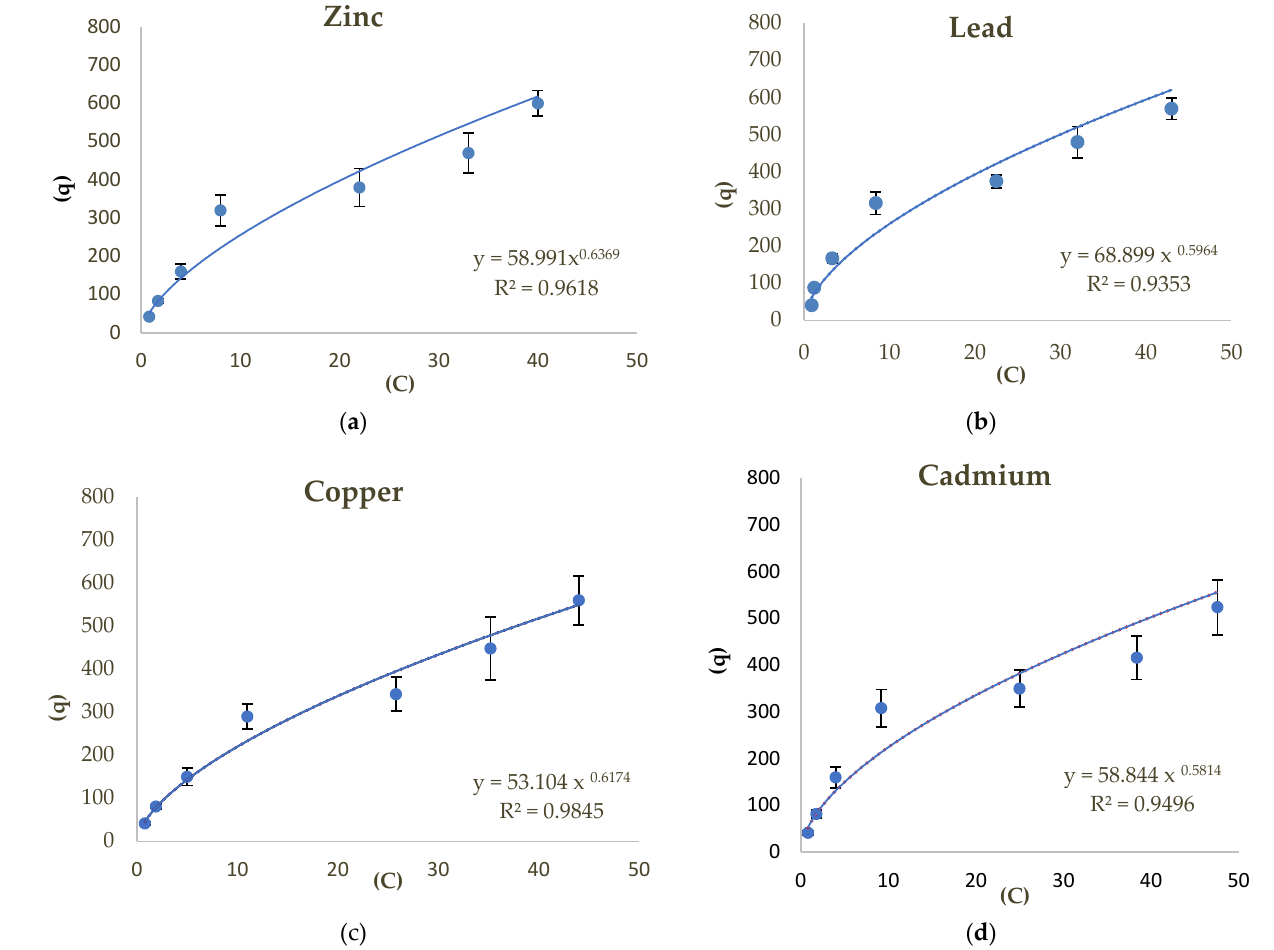
Figure 2. The Freundlich isotherm adsorption of Zn, Pb, Cu, and Cd ( a – d ) in the acidic soil sample. Table 2. Freundlich and Langmuir isotherm parameters for Zn, Pb, Cu, and Cd in both studied soils. Freundlich Parameters Langmuir